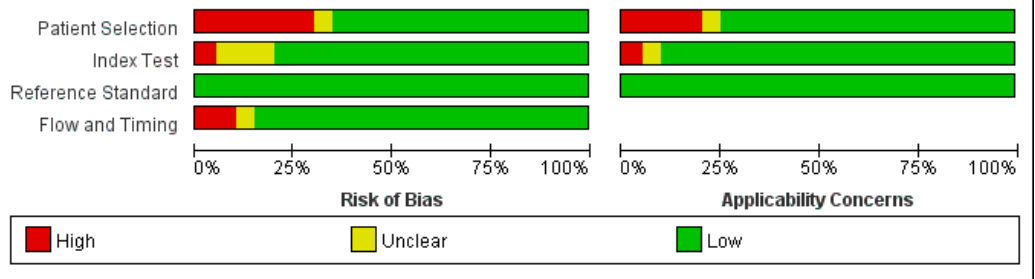
Antibiotics 2021 , 10 , x FOR PEER REVIEW Figure 2. Quality evaluation of the included studies. Figure 2. Quality evaluation of the included studies.